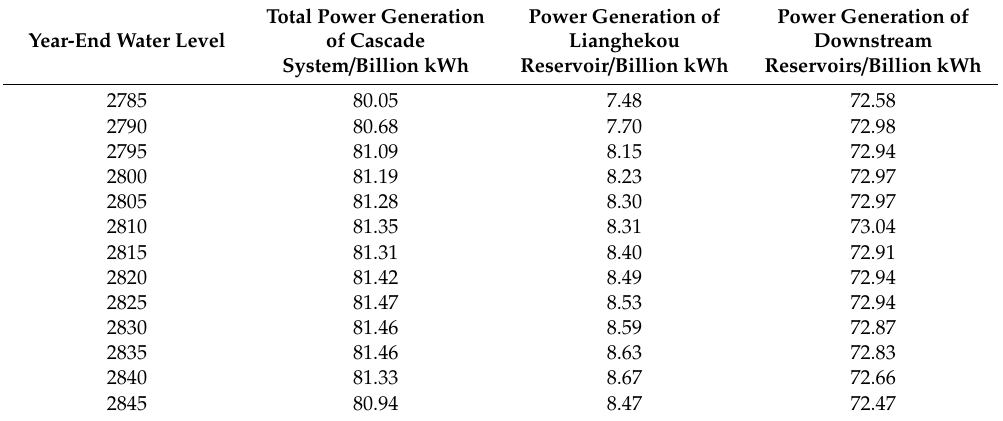
Calculation results of the third dry year under di ff erent year-end water levels of Lianghekou